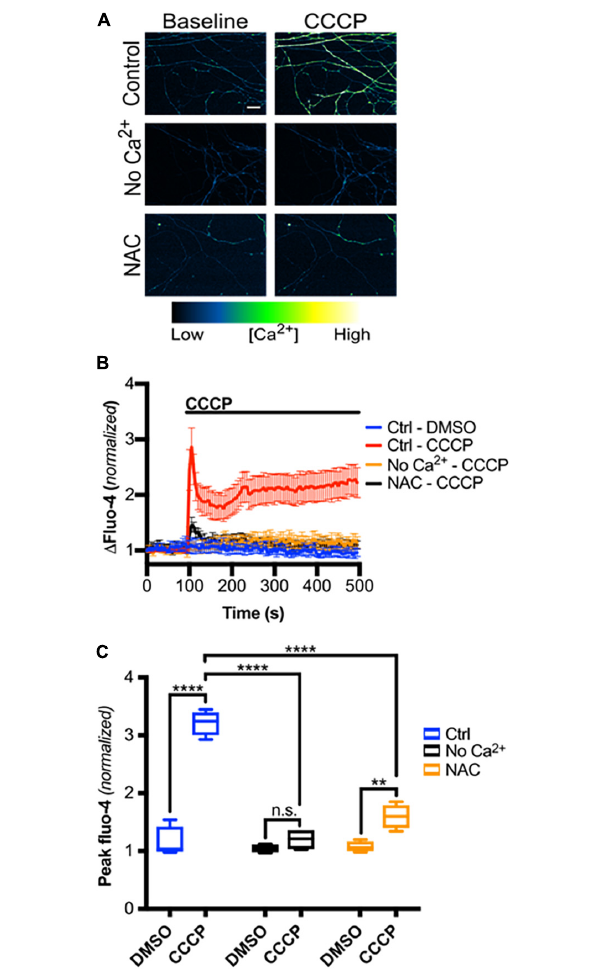
FIGURE 6 | TRPV1 is required for axoplasmic calcium rise following mitochondrial depolarization in intact axons. (A) Micrographs of Fluo-4-AM-loaded axons, treated with CPZ (10 µ M – 30 min pre-incubation) or DMSO (0.1% v/v – 30 min pre-incubation), before and immediately after CCCP treatment (50 µ M) (scale bar indicates 25 µ m). (B) Changes in Fluo-4 intensity before and after CCCP treatment, normalized to intensities at t = 0 s [ n = 8 (DMSO – DMSO, DMSO – CCCP), 6 (CPZ – CCCP)]. Values are mean ± SEM. (C) Peak Fluo-4-AM intensities immediately following CCCP treatment (taken from panel B ), normalized to intensities at t = 0 s. Values are minimum, 1st quartile, median, 3rd quartile, maximum. Statistical significance was assessed using a two-factor ANOVA followed by Tukey’s post hoc comparison, * p < 0.05, ** p < 0.01, **** p < 0.0001.